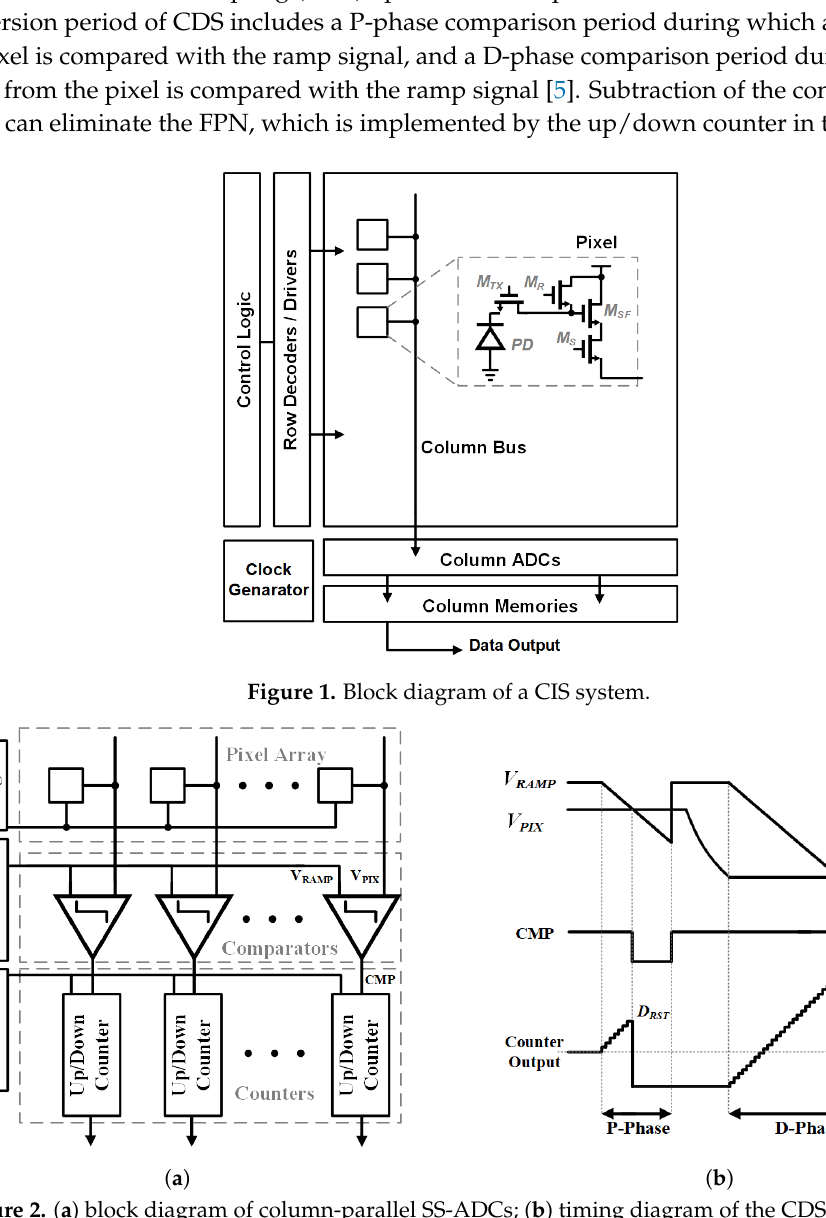
Figure 2. ( a ) block diagram of column-parallel SS-ADCs; ( b ) timing diagram of the CDS